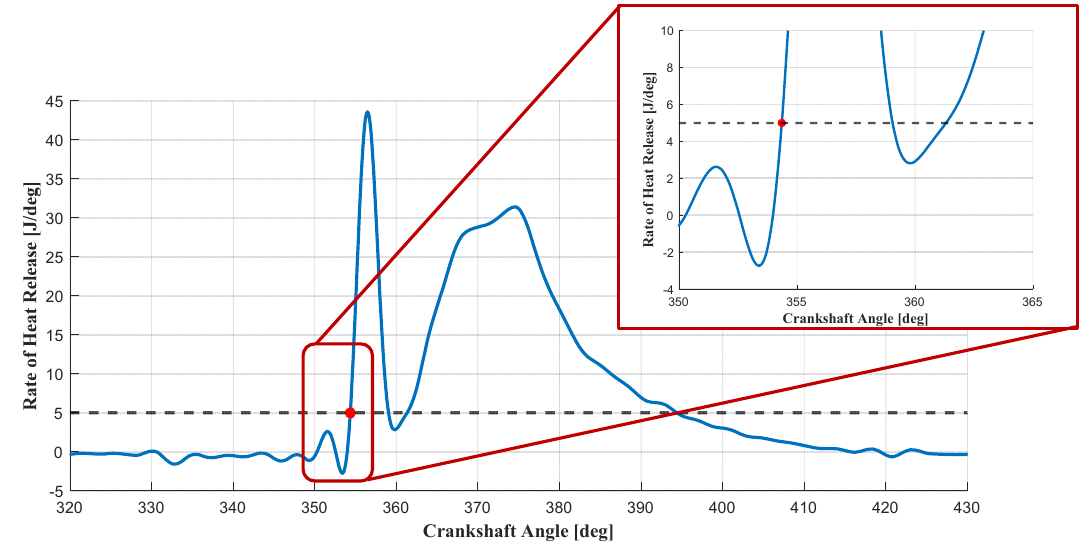
Figure 3. ROHR curve and corresponding ROHR threshold for determining the SOC.